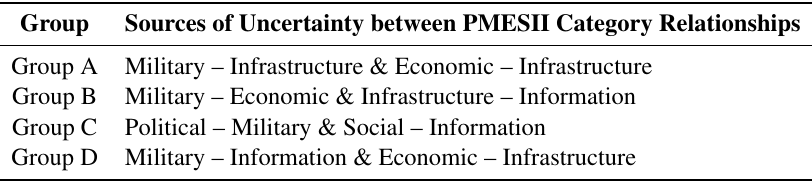
Listing of initial group identification of critical uncertainties.